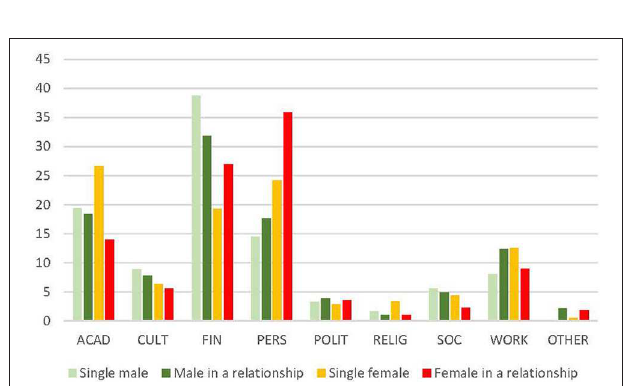
FIGURE 6 | Top reason to leave (gender and relationship) (%). ACAD, academic; CULT, cultural environment; FIN, financial; PERS, personal; POLIT, political; RELIG, religious; SOC, social. Data reported in